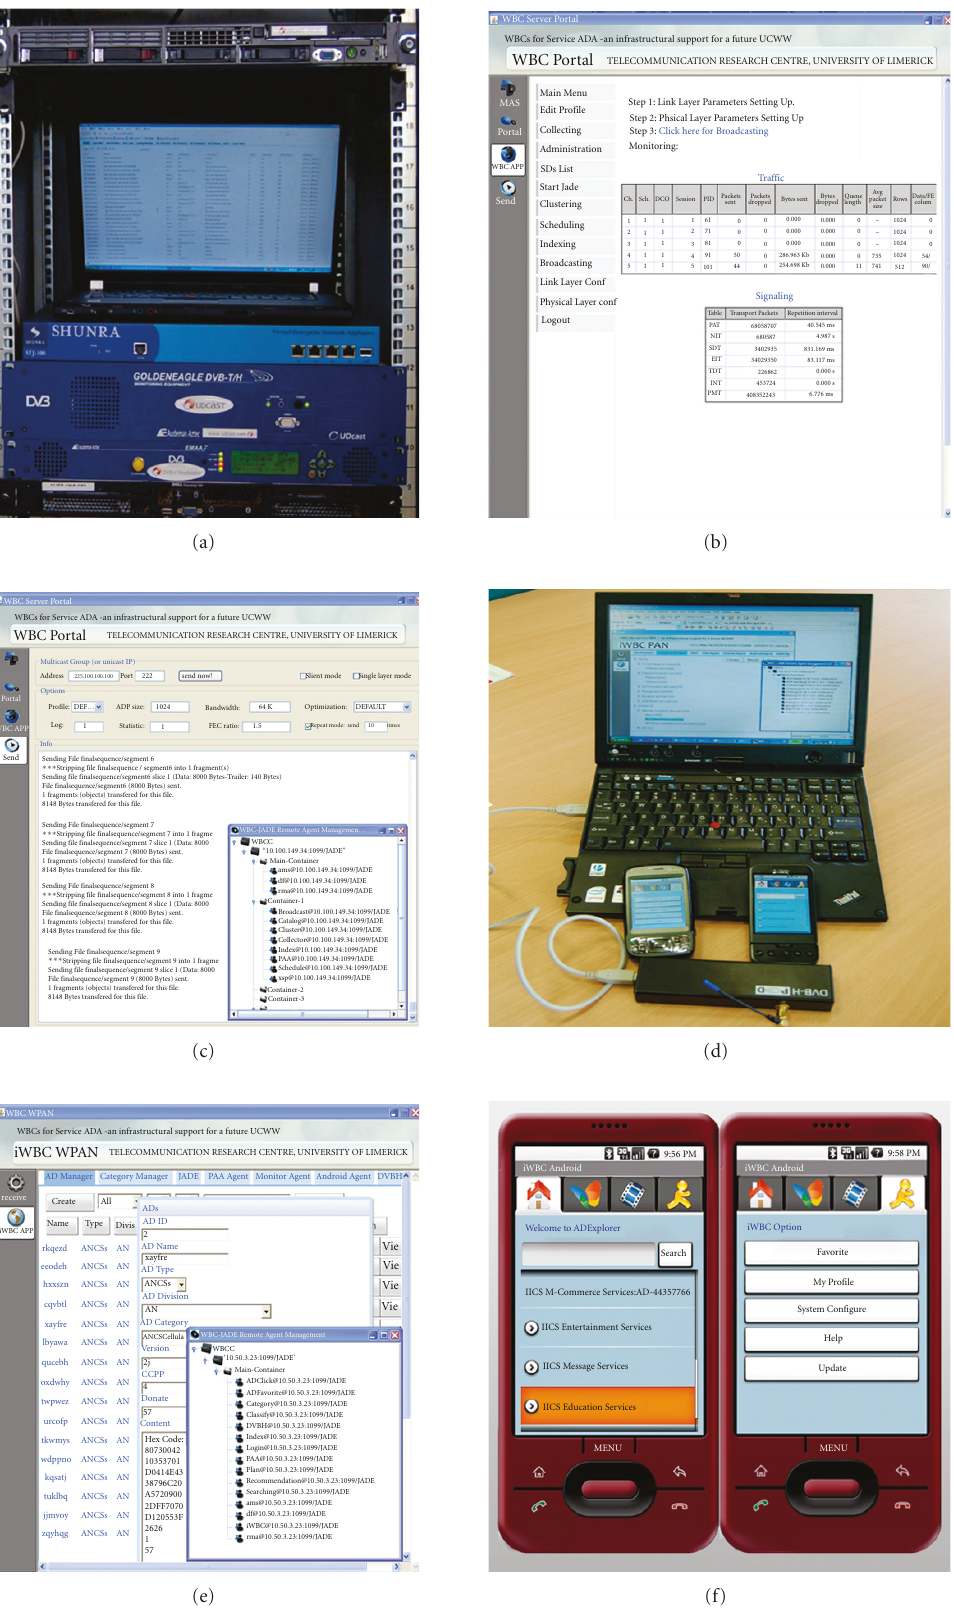
Figure 12: The “WBC over DVB-H” system and GUI. (a) WBC-SP’s rack; (b) WBC portal for tra ffi c monitoring; (c) WBC portal for broadcasting; (d) mobile user’s WPAN; (e) iWBC GWT application; (f) iWBC-Android